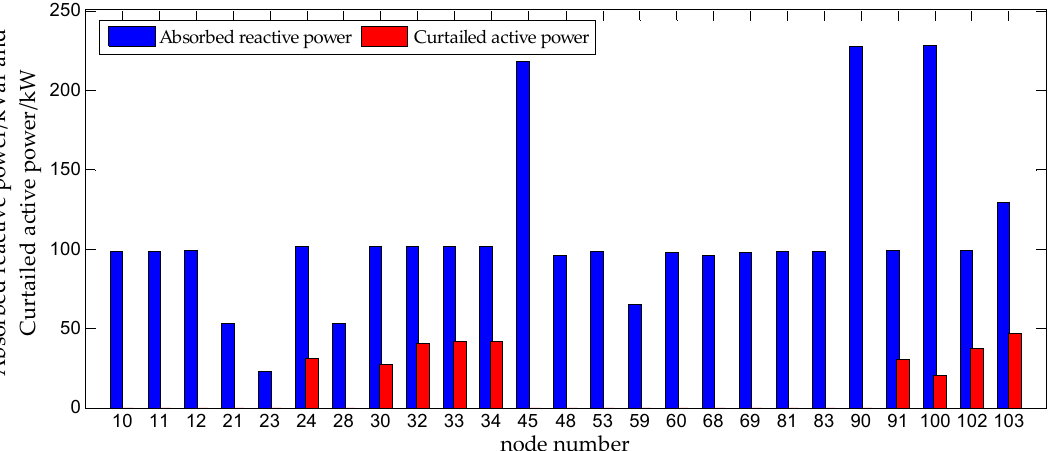
Figure 13. Absorbed reactive power and curtailed active power of PV inverters under the centralized control scheme.